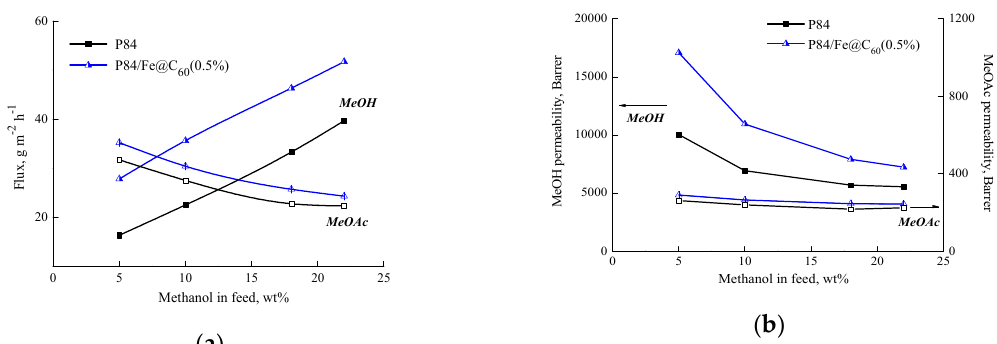
Figure 6. Dependence of ( a ) flux and ( b ) permeability of individual components (methanol and methyl acetate) on methanol concentration in the feed for the pervaporation of the methanol—methyl acetate mixture through P84 and P84/Fe@C 60 (0.5%) membranes, 25 ◦ C.